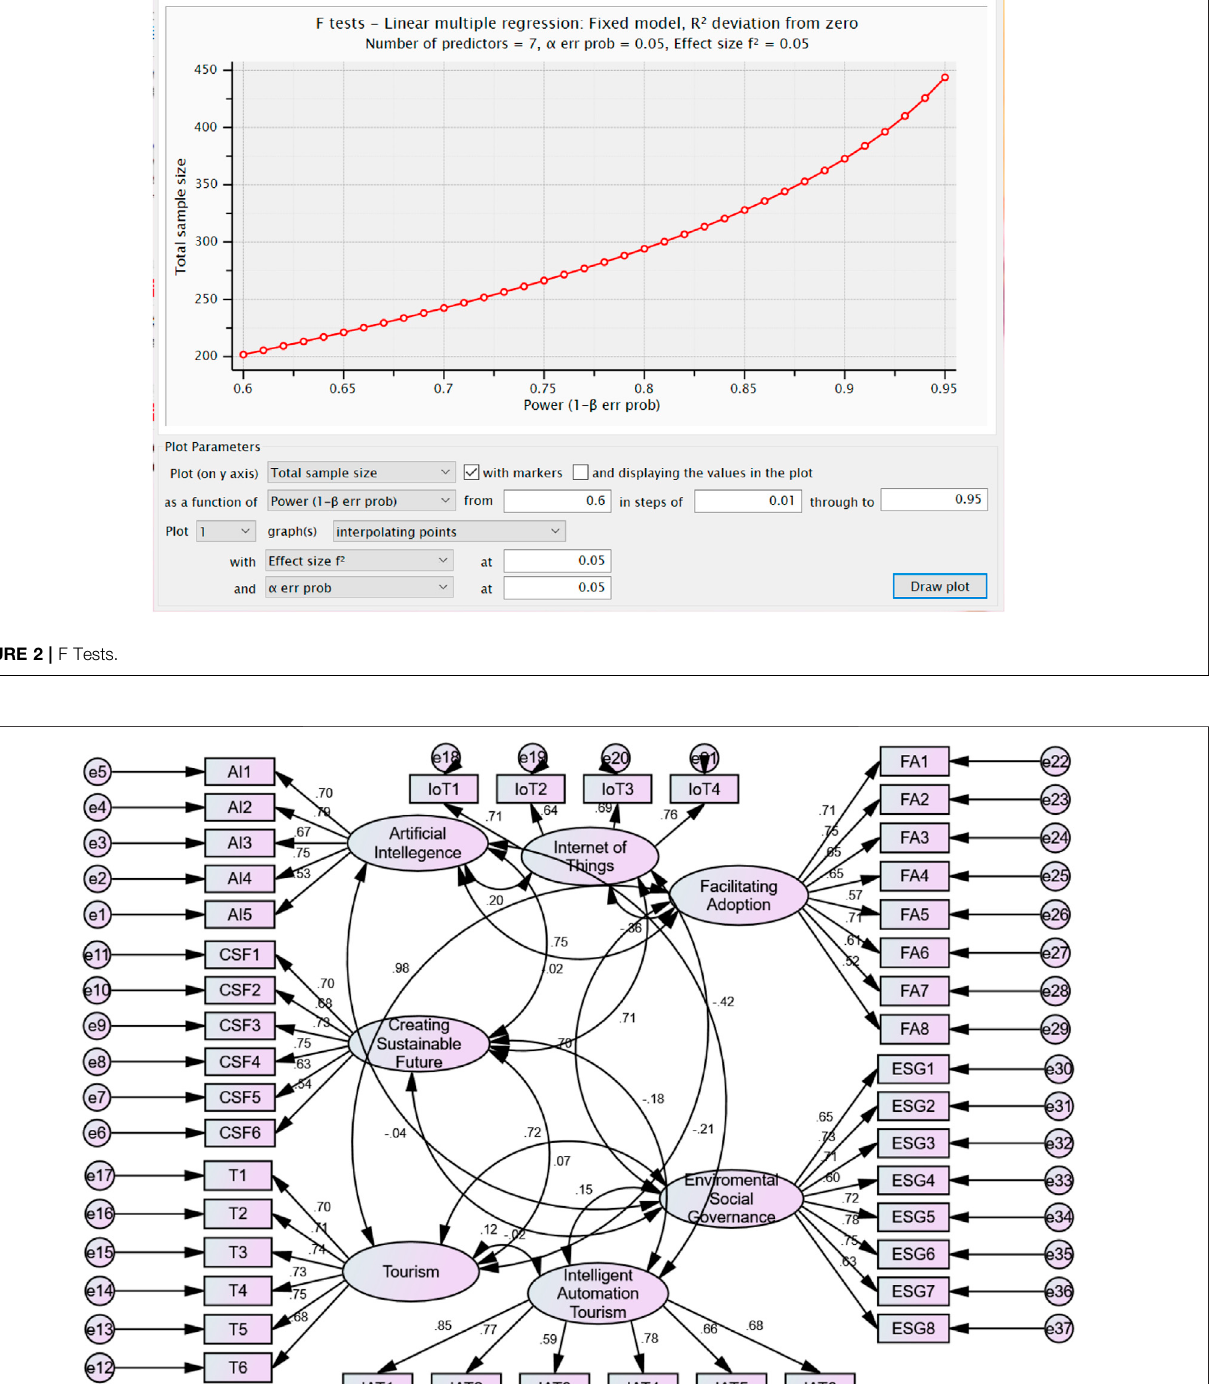
Frontiers in Environmental Science |